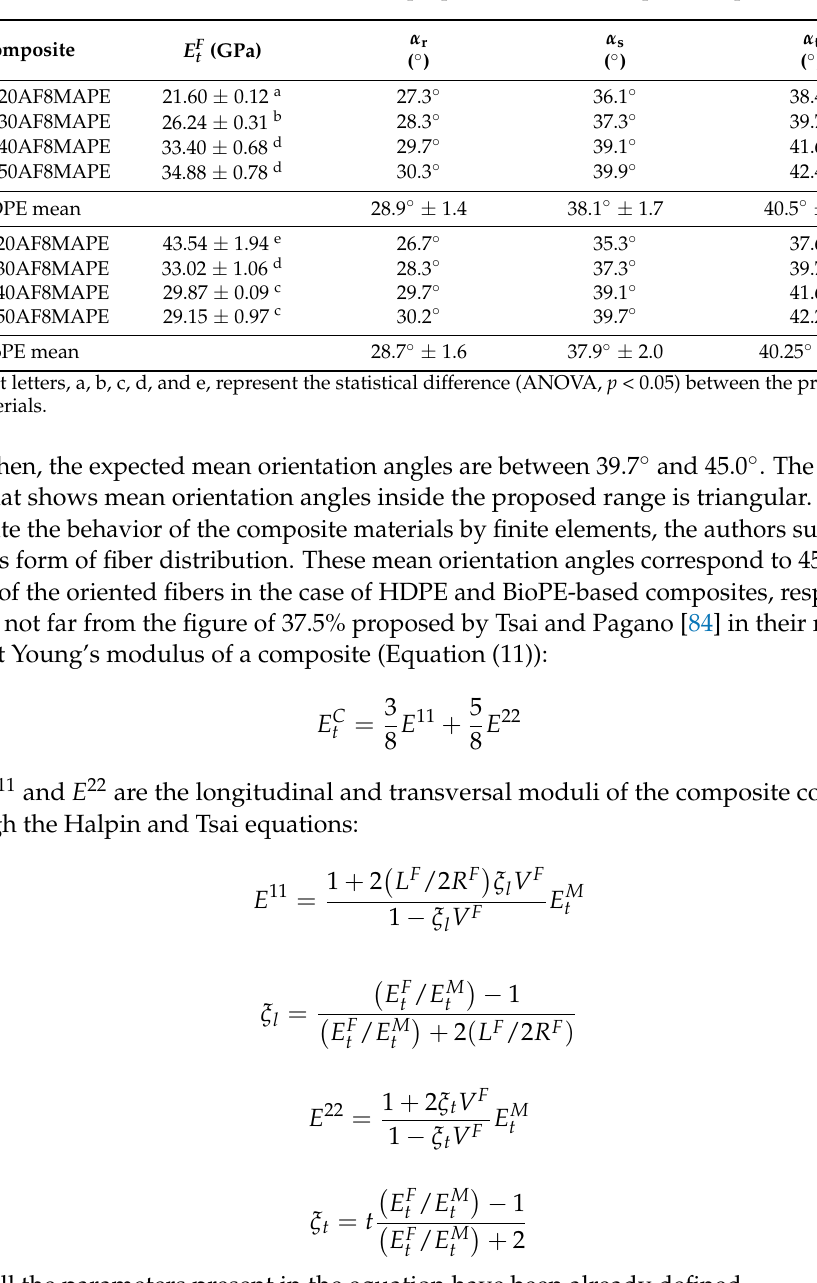
Table 3. Influence of AF content over the tensile properties of 8wt.% coupled